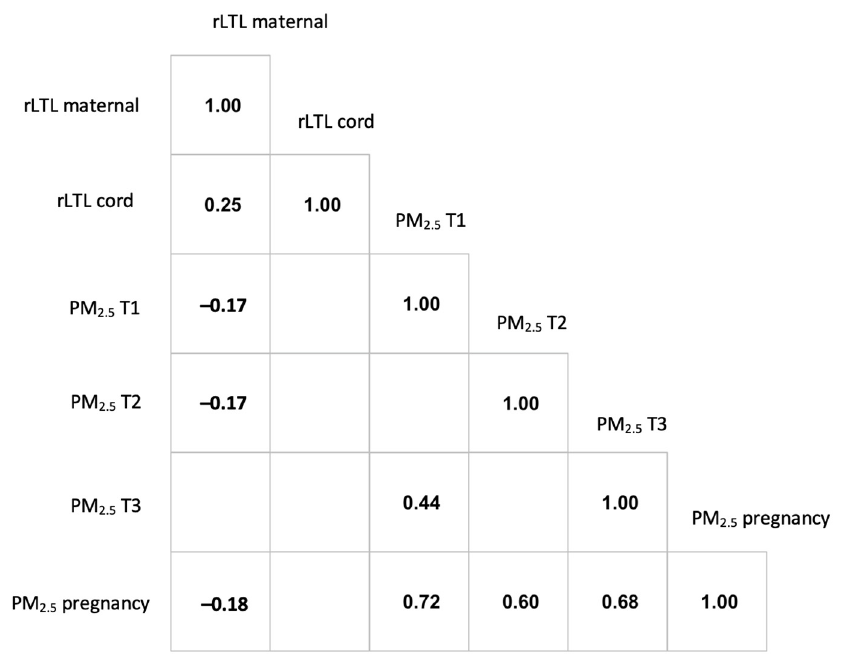
Figure 1. Correlation analysis of maternal rLTL, cord blood rLTL and PM 2.5 exposures averaged across each trimester, as well as PM 2.5 exposures at the total pregnancy period. A blank represents an insignificant p-value at the significance level 0.05.